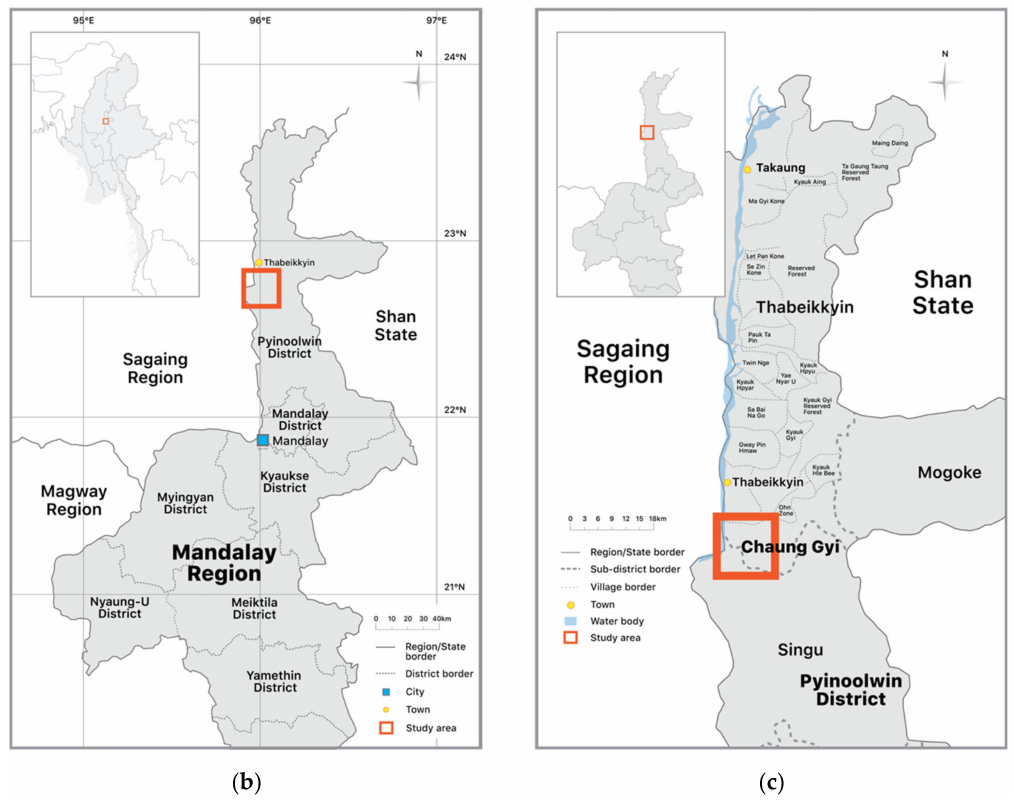
Figure 1. Study area. ( a ) Map of Myanmar with states and regions. ( b ) Map of the Mandalay Region with districts. ( c ) Chaung Gyi Village, Thabeikkyin Township, Pyinoolwin District, Mandalay